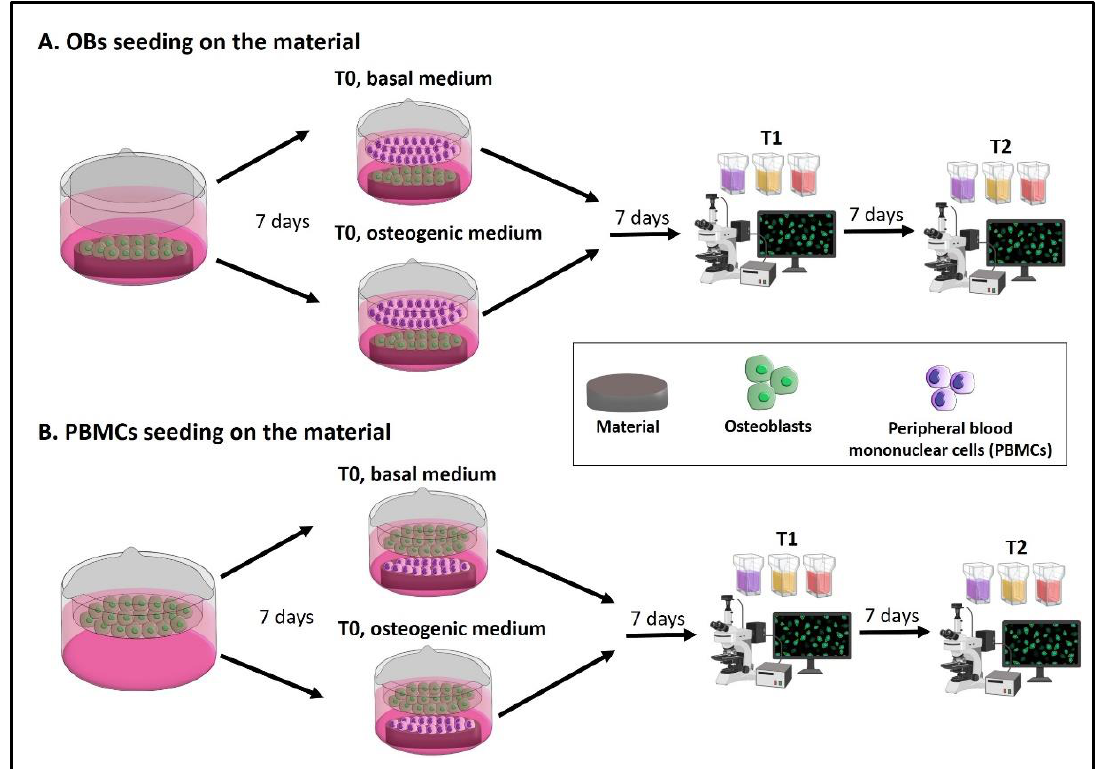
Figure 1. Experimental design of the protocol. Two types of indirect co-cultures can be set up, by choosing what cell type may be seeded on the material and which one may be co-cultured. ( A ) OBs on the material: OBs are seeded on the material and left 7 days until cell confluence. Then, PBMCs are seeded into the transwell and the indirect co-culture starts. ( B ) PBMCs on the material: OBs are seeded into the transwell and left 7 days until cell confluence. Then, PBMCs are seeded on the material and the indirect co-culture starts. After 7 days (T1) and 14 days (T2) the following assays are performed: Alizarin Red S, von Kossa and alkaline phosphatase (ALP) staining on OBs, while tartrate-resistant acid phosphatase (TRAP), Hoechst and phalloidin-tetramethylrhodamine B isothiocyanate (TRITC) or phalloidin-fluorescein isothiocyanate (FITC) staining are used on PBMCs.